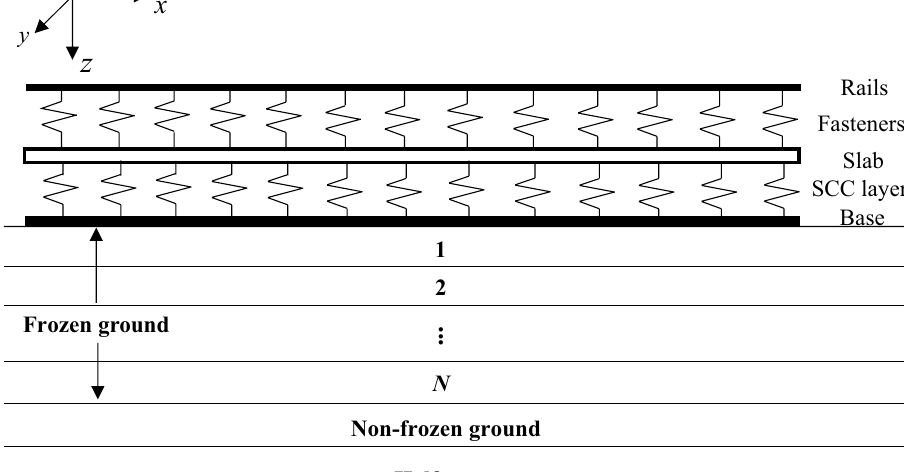
Figure 15. A sketch of the CRTS III slab track/frozen ground and the coordinate system.